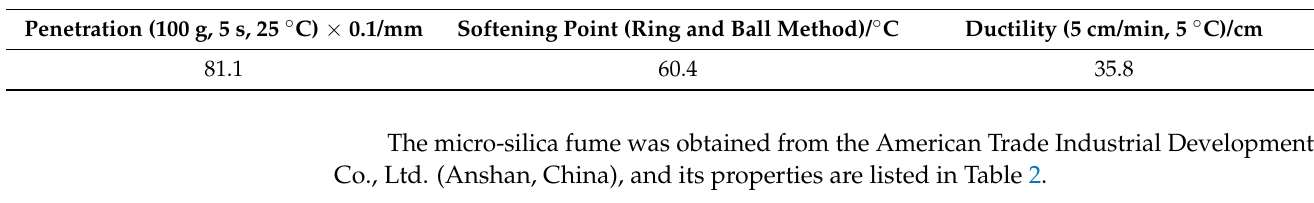
Table 1. Properties of the 4% styrene-butadiene-styrene-modified asphalt.